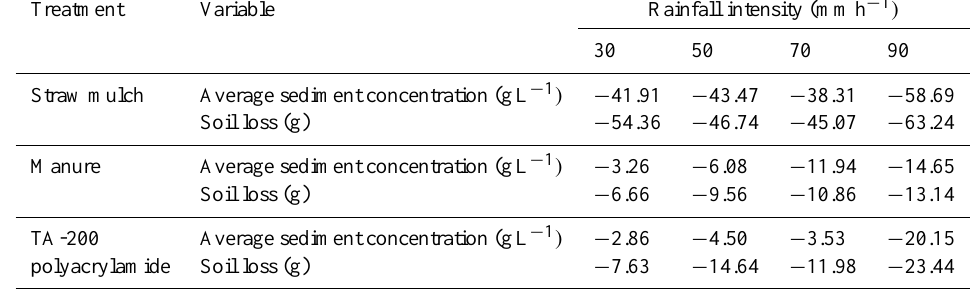
Table 3. Reduction rates in average sediment concentration and soil loss (%) resulted from application of straw mulch, manure and TA-200 polyacrylamide and from various rainfall intensities.